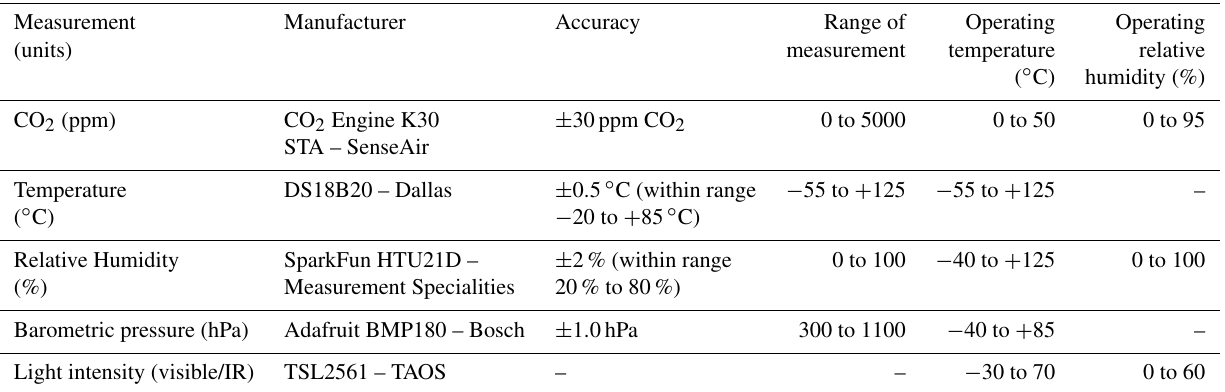
Figure 1. An air enquirer kit, with sensors for measuring temperature, humidity, barometric pressure, light intensity, and CO 2 concentration in air. Table 1. Characteristics of the sensors included within the air enquirer